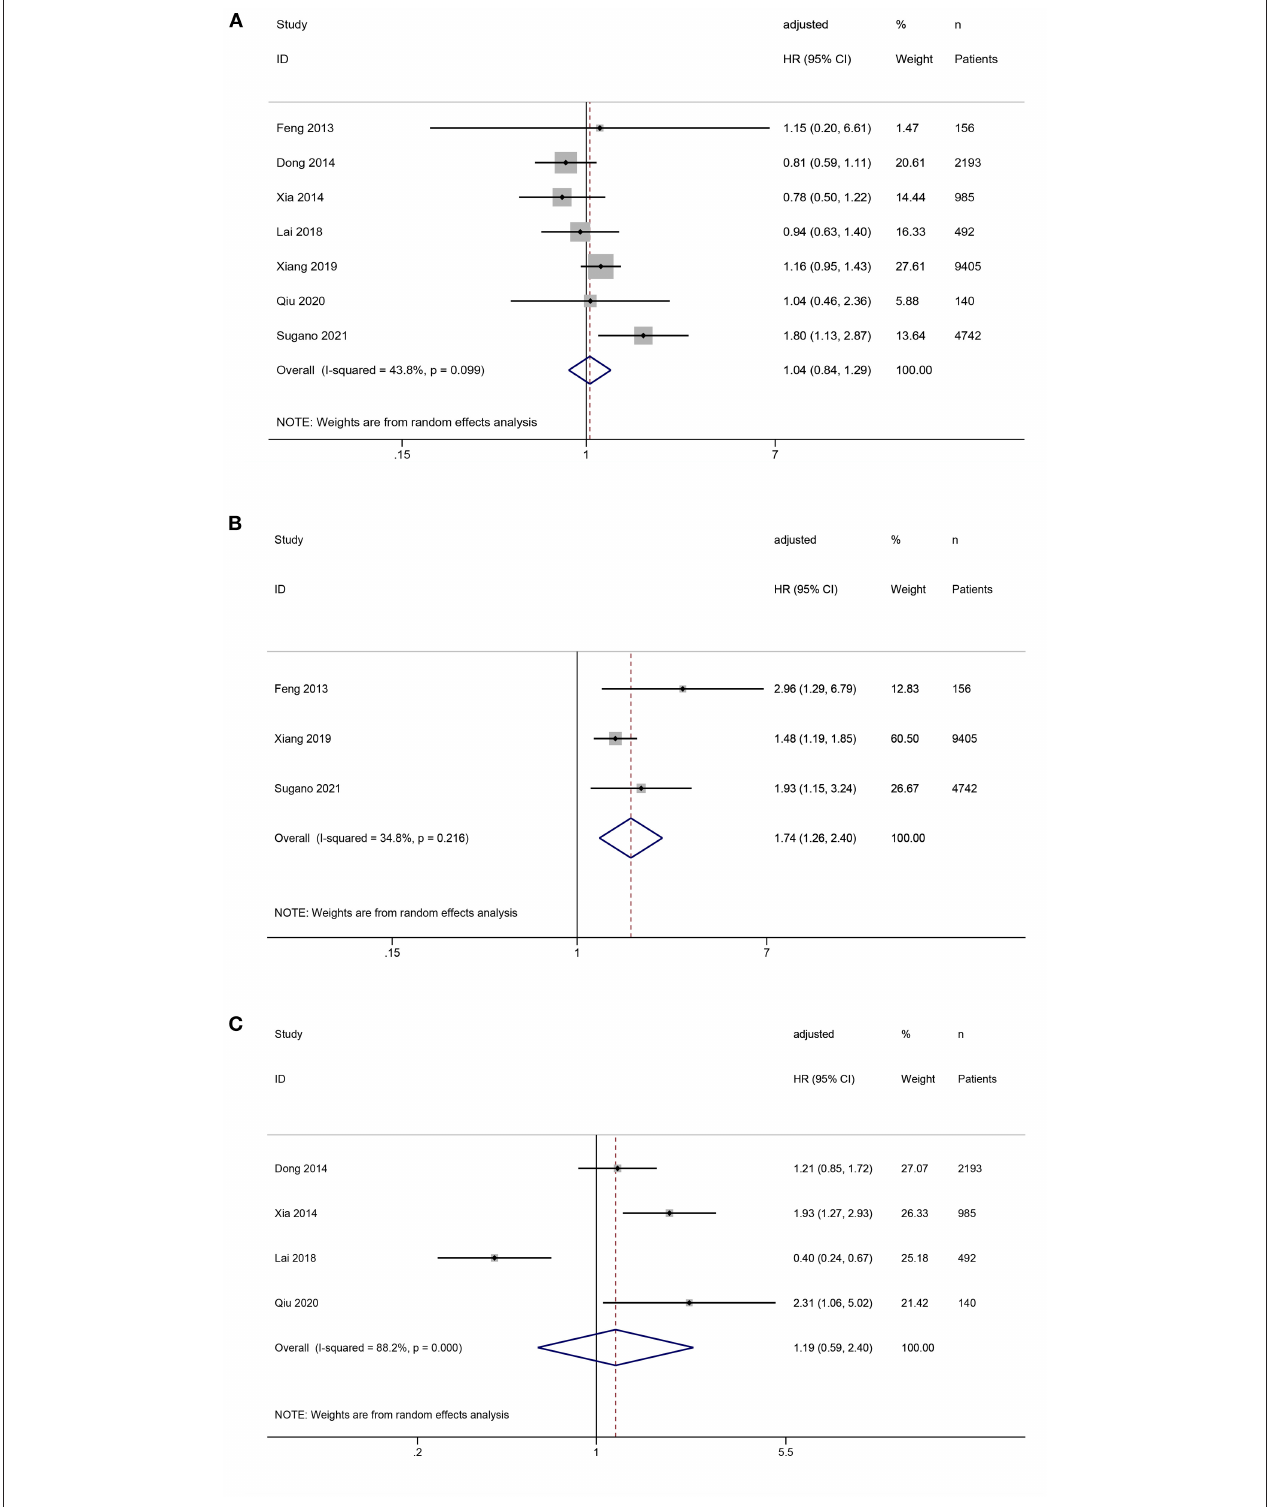
FIGURE 2 | Forest plot of the association between serum uric acid levels and all-cause mortality in PD patients. (A) low vs. middle; (B) high vs. middle; (C) high vs. low.